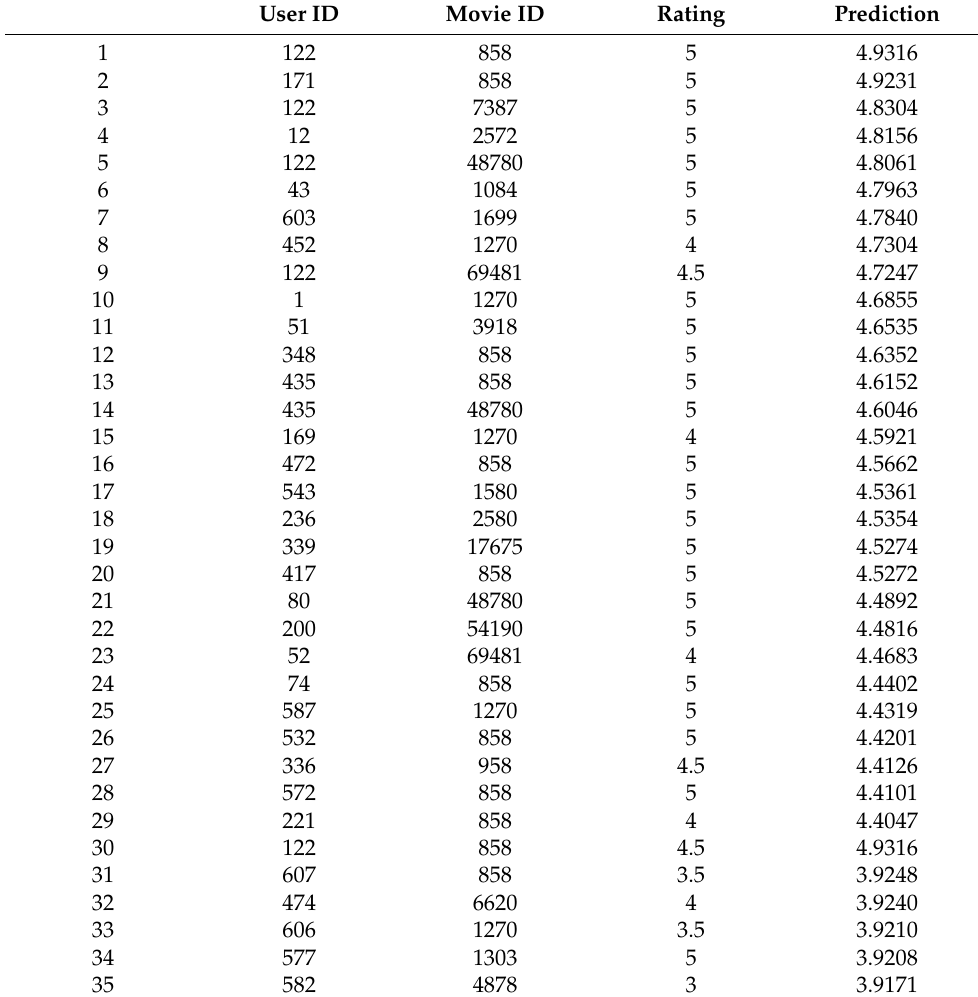
Table 6. The top 35 predictions achieved for up to 1000 movies.